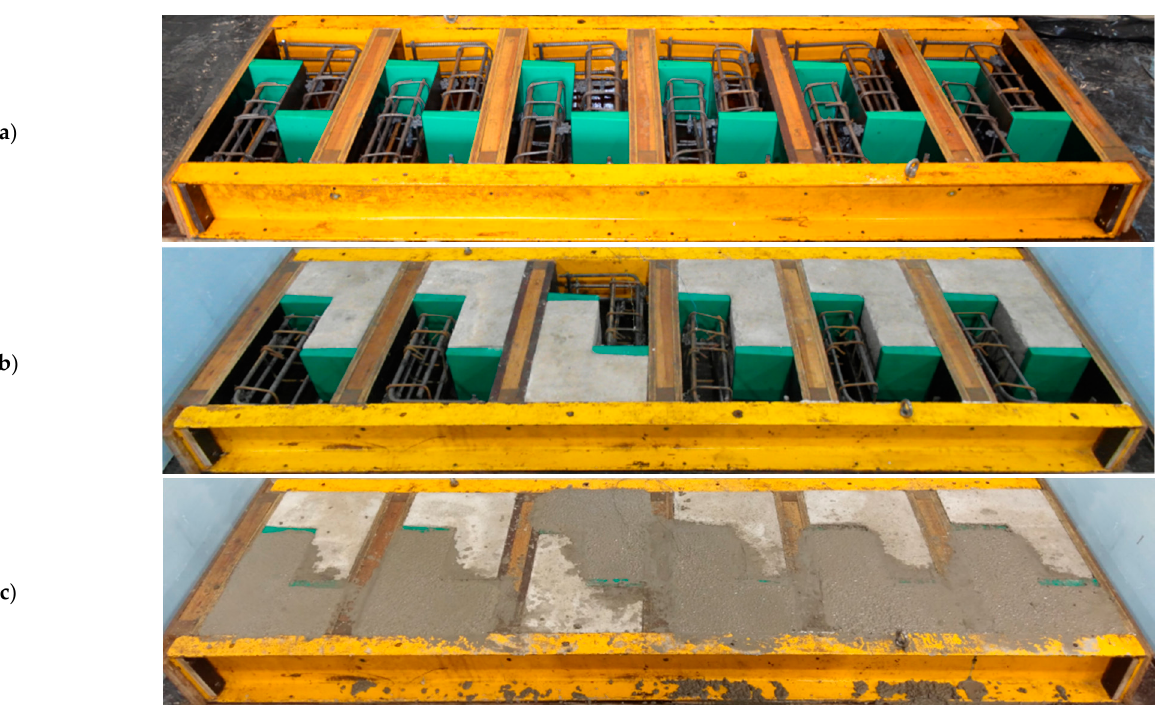
Figure 6. Subsequent stages of casting test specimens: ( a ) Placing of the reinforcement, ( b ) casting of parts constituting the substrate, ( c ) placing concrete overlay.